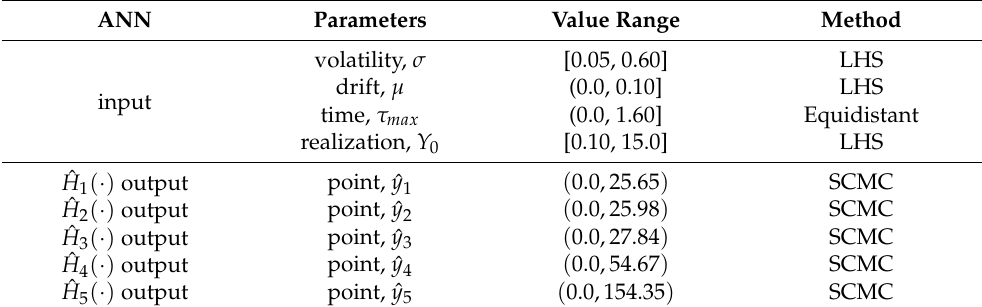
Table 1. Training data, ∆ τ = 0.01. Here is an example for training on five SC points. ANN Parameters Value Range Method volatility, σ [0.05, 0.60] LHS drift, µ (0.0, 0.10] LHS input time, τ max (0.0, 1.60] Equidistant realization, Y 0 [0.10,